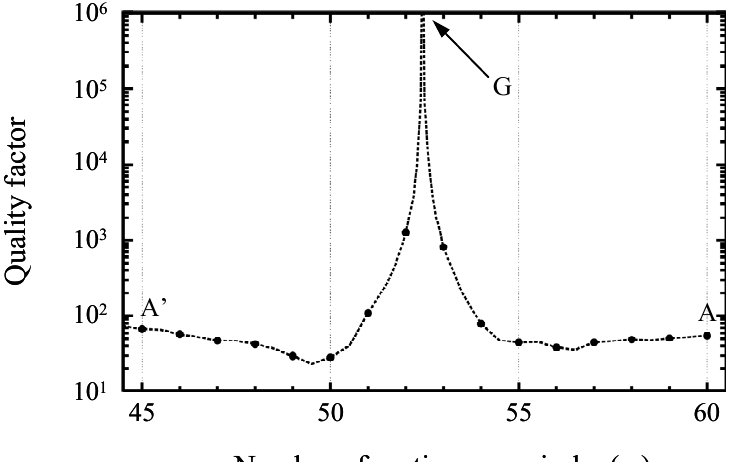
Figure 8. Quality factor of the resonance series indicated by A-A’ in Figure